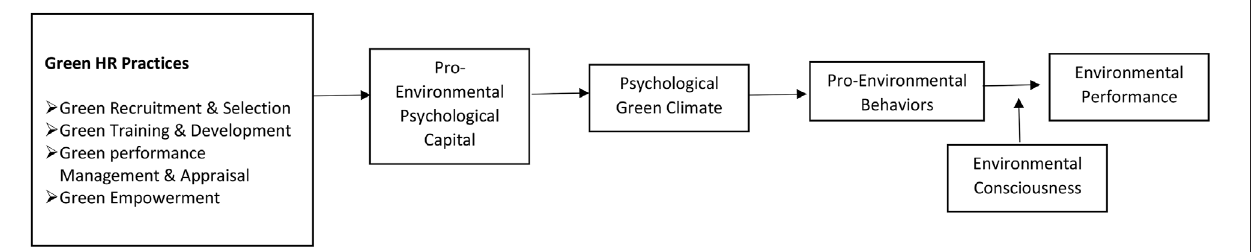
FIGURE 1 | Theoretical